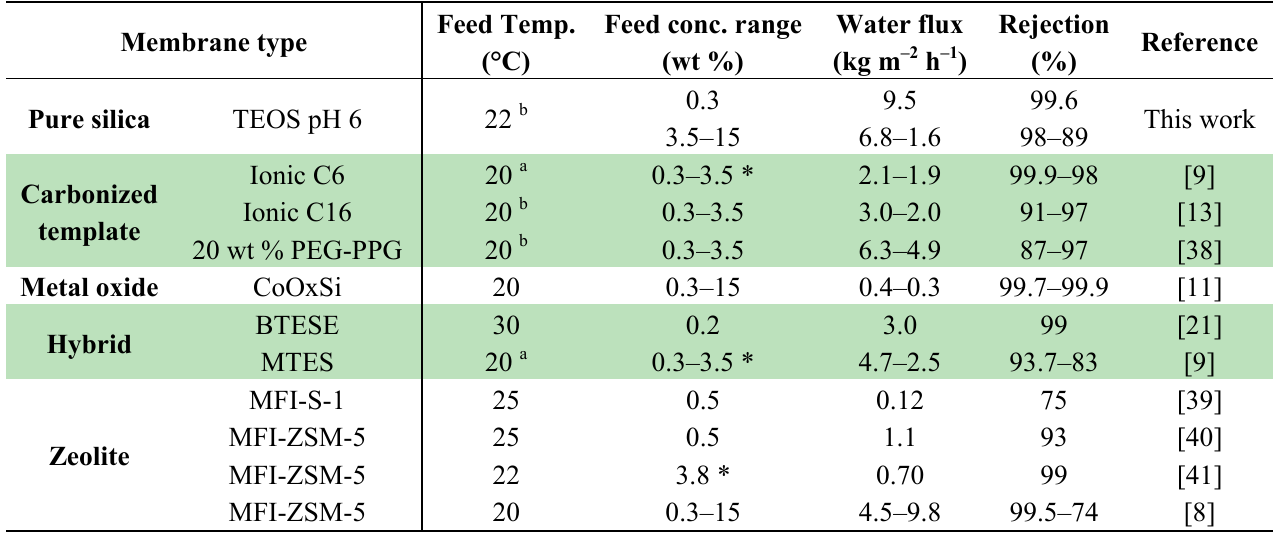
Table 2. Performance comparison of silica based membranes for desalination.